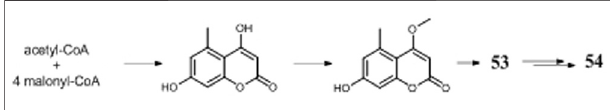
FIGURE 5 | Proposed biosynthetic pathway of orlandin ( 53 ) and kotanin ( 54 ).